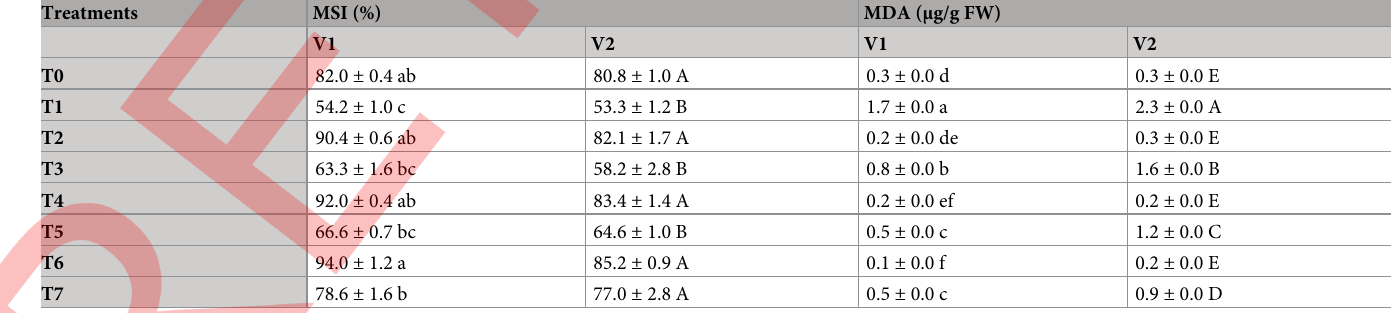
Table 2. Effect of biochar and compost on membrane stability index and malondialdehyde content of Spinach in cadmium contaminated soil. The mean of three replicates and standard deviation are presented. Different letters show the significant difference among treatments. Treatments as mentioned in Table 1.